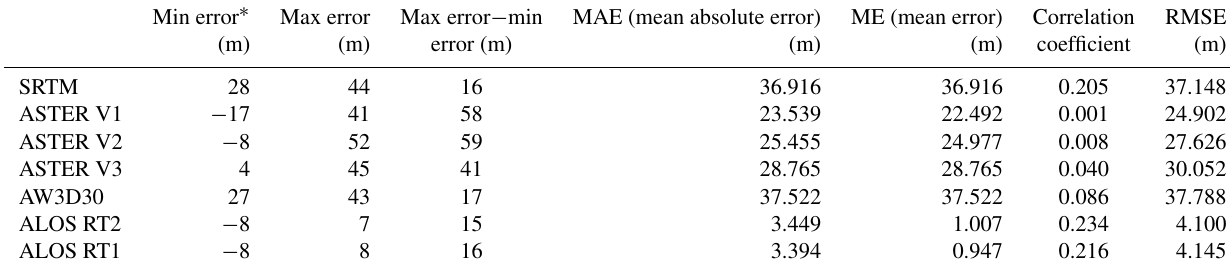
Table A2. Statistical analysis of seven DEMs in the flat eastern area.